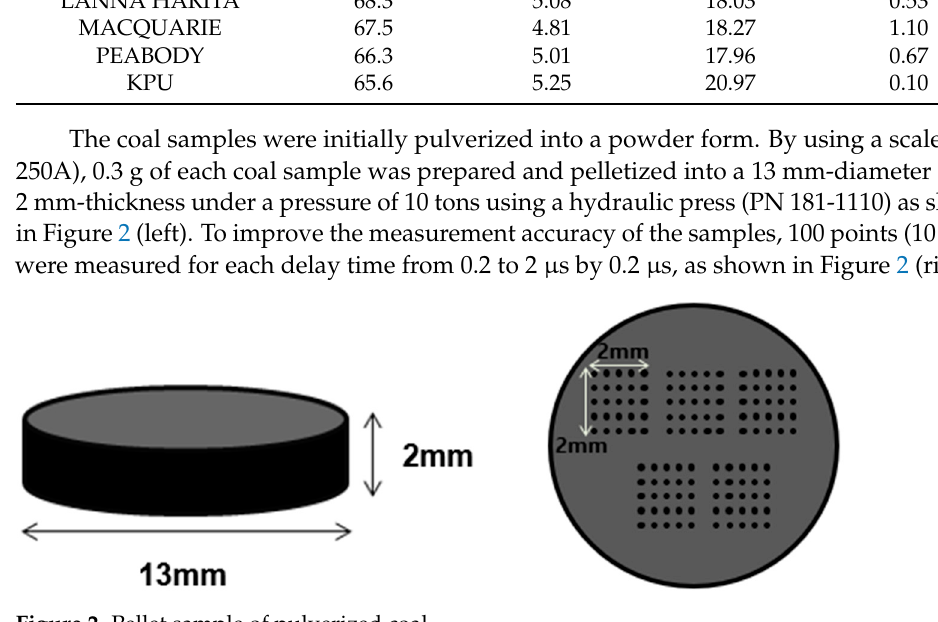
Figure 2. Pellet sample of pulverized coal. Table 1. Description of coal sample.